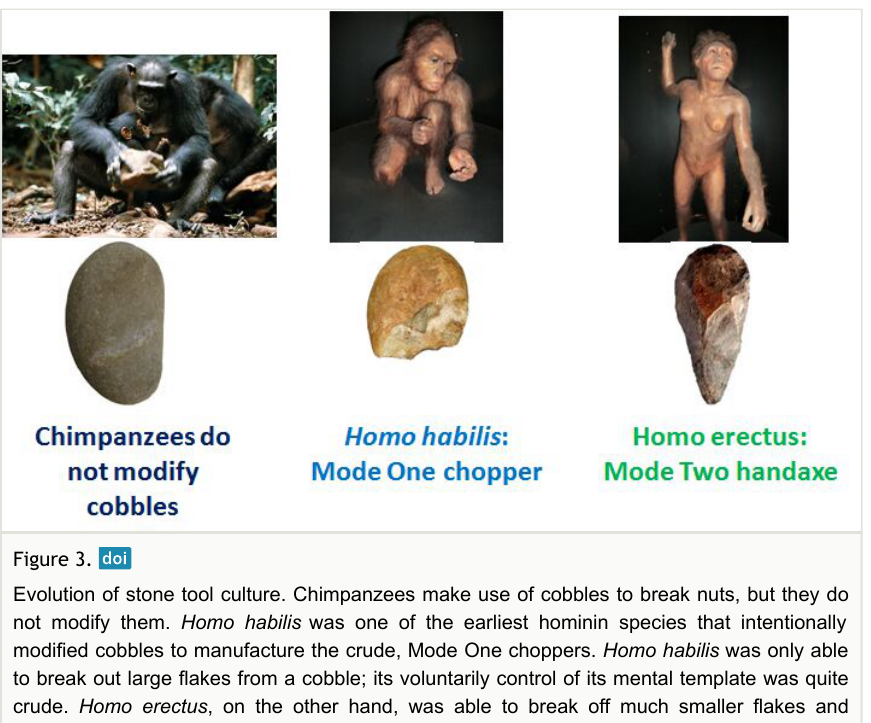
Evolution of stone tool culture. Chimpanzees make use of cobbles to break nuts, but they do not modify them. Homo habilis was one of the earliest hominin species that intentionally modified cobbles to manufacture the crude, Mode One choppers. Homo habilis was only able to break out large flakes from a cobble; its voluntarily control of its mental template was quite crude. Homo erectus , on the other hand, was able to break off much smaller flakes and produce the fine, symmetrical, Mode Two handaxes; therefore, Homo erectus was most likely capable of finer voluntary control of its mental template. (Ape reproductions as photographed by the author at the evolution exhibit the Valladoki Science Museum, Apes do not manufacture stone tools in the wild and attempts to teach stone tools manufacturing to apes have failed (Toth et al. 1993), suggesting that this ability was acquired after humans split from the chimpanzee line 6 million years ago. The first stone tools, Mode One choppers, dated to about 3.3 (Harmand et al. 2015) to 2.5 (Semaw et al. 1997) million years ago (ya) are crude and asymmetrical. Starting from about 2 million ya, hominins were capable of manufacturing fine symmetrical Mode Two handaxes with a long cutting edge (Klein 2009). Neanderthals manufactured even better Mode Three Mousterian tools found in the archaeological record from about 0.4 million ya (Klein and Edgar 2002). It is likely that the main reason for stasis in each stone tools culture was not the inability to find proper materials or inferior hand dexterity (Crast et al. 2009), but limitation in voluntary imagination. Hominins who could not imagine the final tool could not manufacture it either. If the quality of stone tools is informing us of the LPFC ability to control their mental template, then stone tools provide a time record of voluntary imagination gradually improving in hominins over the last 3.3 million years.